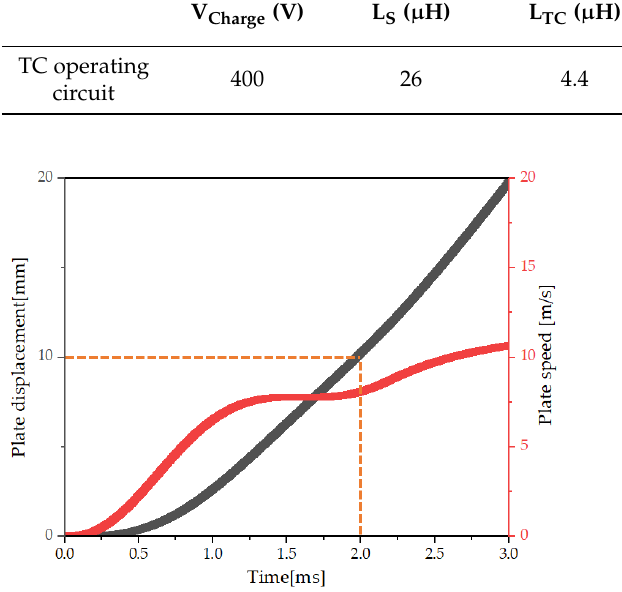
Table 2. Thomson coil operating circuit parameters.